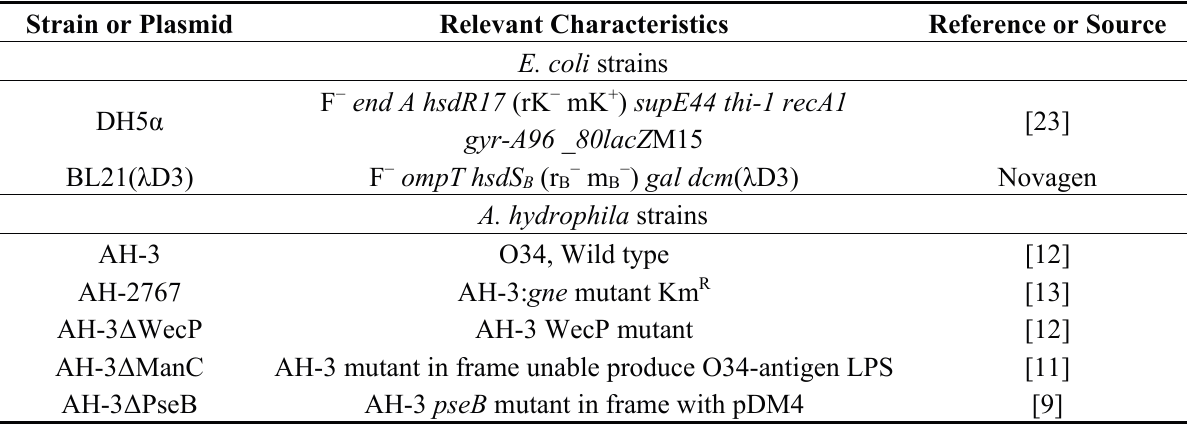
Table 3. Bacterial strains and plasmids